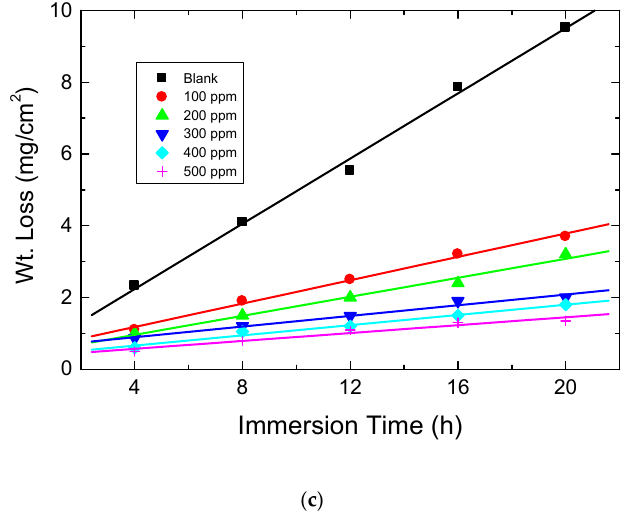
Figure 9. WL vs. time plots for mild steel in 0.5 M HCl solution at 303 K in absence and presence of the examined carbohydrate polymers: ( a ) Chi, ( b ) Pec, and ( c ) A-Pec. Table 4. Values of CR of mild steel, %IE, and θ of the tested carbohydrate polymers, Chi, Pec, and A-Pec, in 0.5 M HCl solution at diverse temperatures.